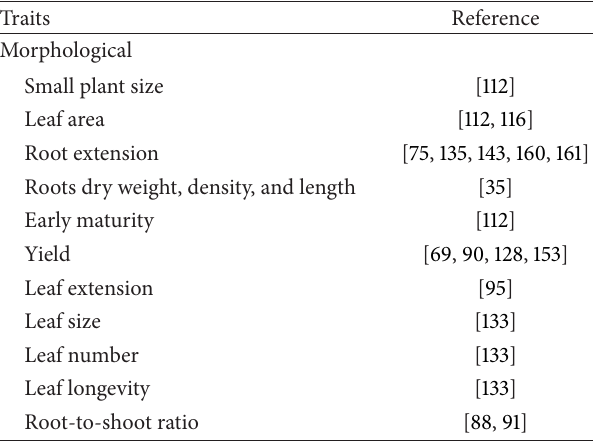
Table 5: Research scenario of morphological traits under drought stress in wheat.